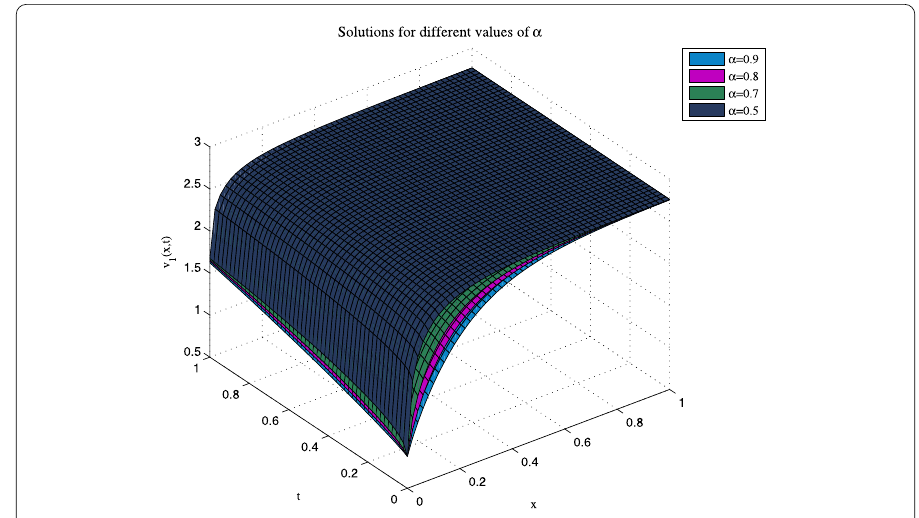
Figure 8 Exact solution v 1 ( x , t ) of fractional DSW system at α = 0.9,0.8,0.7,0.5, c = 0.1, k = 0.8, p = 0.006, q = 0.009, r = 0.04, s = 1, γ =